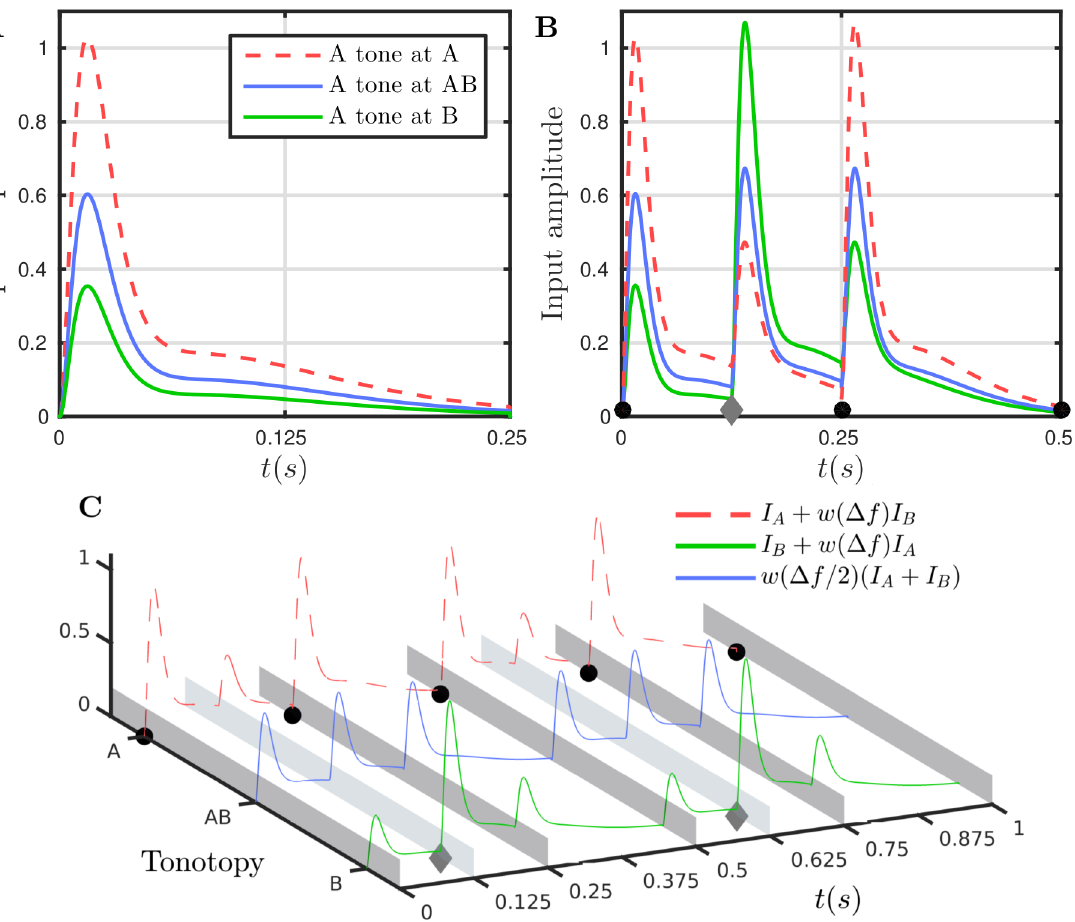
Fig 3. Model inputs. A : Input time courses are represented by double alpha functions (see Model equations and details and Eq (8)) that capture the onset and plateau characteristics of A1-responses from [28]. For a single 125 ms tone of frequency A less input will arrive at locations AB and B than at A as described by Eq (7) and plotted here for Δ f = 4 [26]. B : Inputs (see legend in C) to the respective populations r A , r B and r AB for an ABA- triplet of 0.5 s (tone duration and post-triplet silence “ - ” of 125 ms, i.e. PR = 8 Hz). Tone onsets: black circle for A-tone, gray diamond for B-tone. C : As B with curves distributed across the model ’ s tonotopy. The A-tone input is full amplitude at the A location, less at the AB location and further less at the B location, correspondingly for the B-tone input.